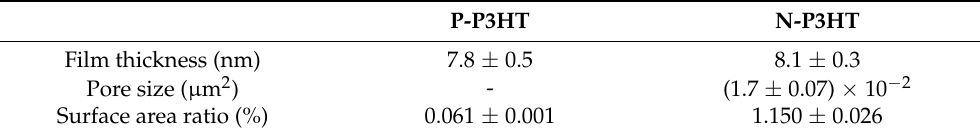
Figure 2. AFM topology images and corresponding film thickness profiles (measured along the red line) of the ( a , b ) N-P3HT film and ( c , d ) pristine P3HT (P-P3HT) film. Table 1. Morphological properties of the P-P3HT and N-P3HT films prepared using the SAPS method at a shear speed of 4 mm s − 1 and a solute/solvent ratio of 5